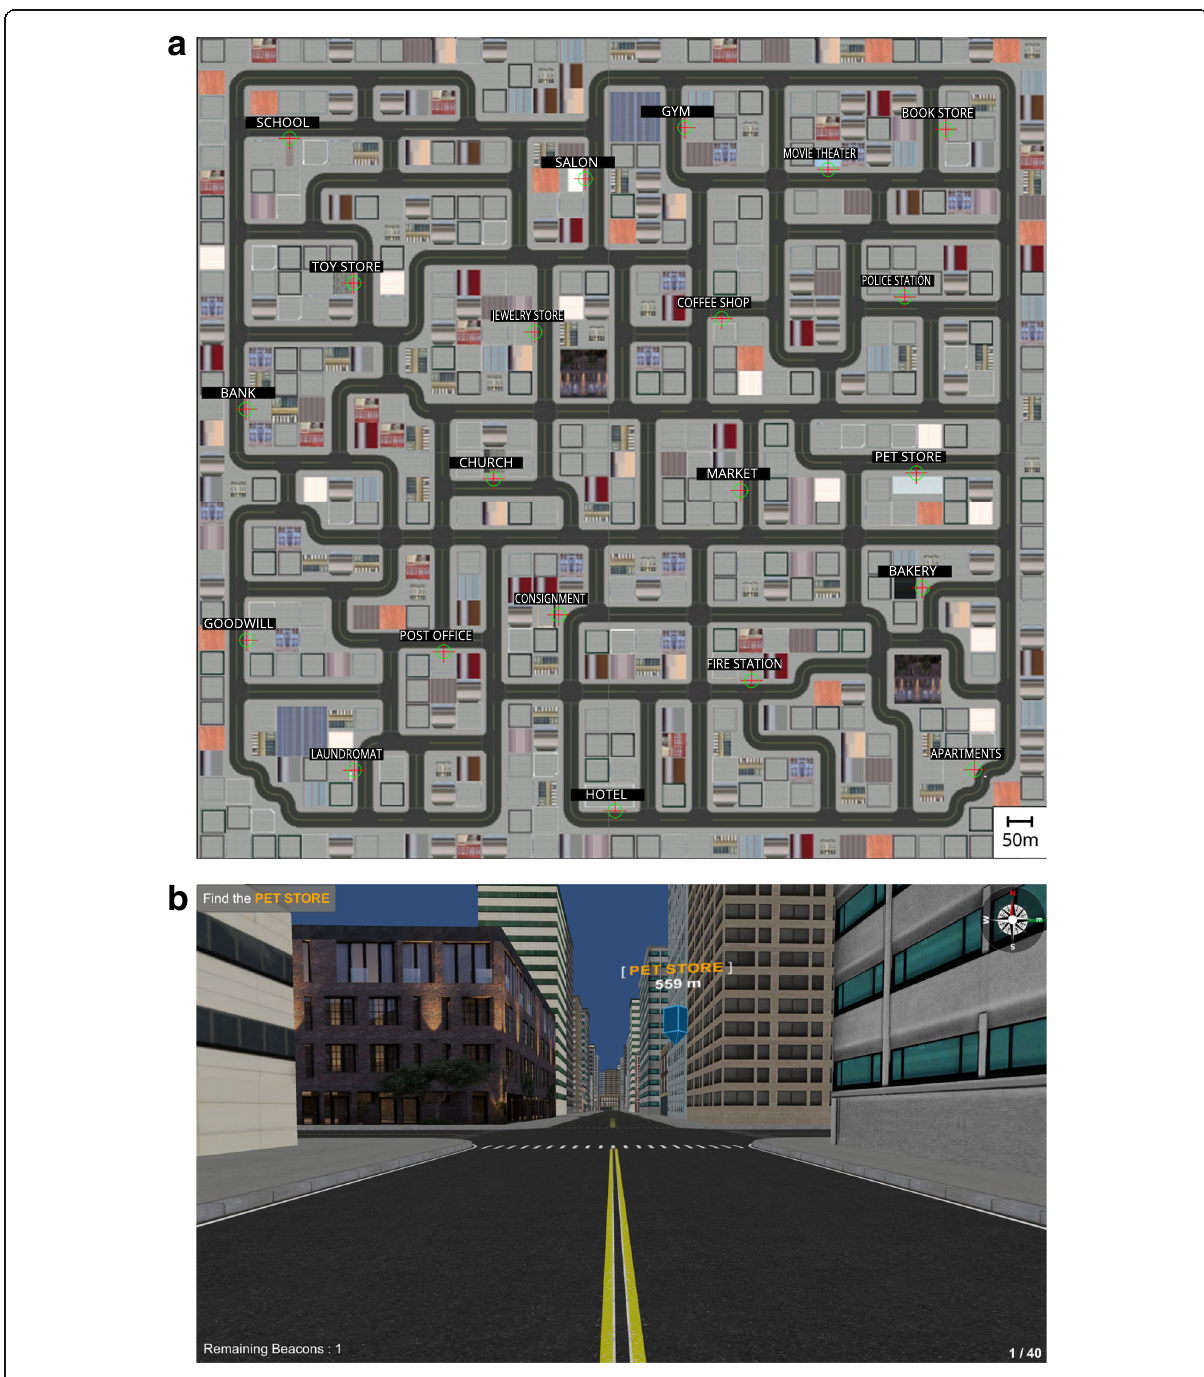
Fig. 1 a , b Upper panel depicts an overhead view (north up) of the virtual environment, with labeled landmarks. Lower panel depicts a view from within the virtual environment (approaching an intersection), demonstrating the current destination ( Find the Pet Store ), remaining number of beacons (1), trial number (1/40), compass rose, and the floating beacon (PET STORE 559